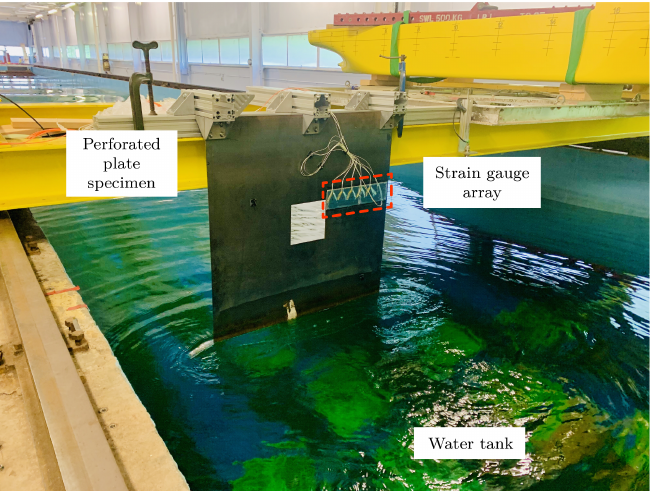
Figure 3. Structural test of perforated plate instrumented with